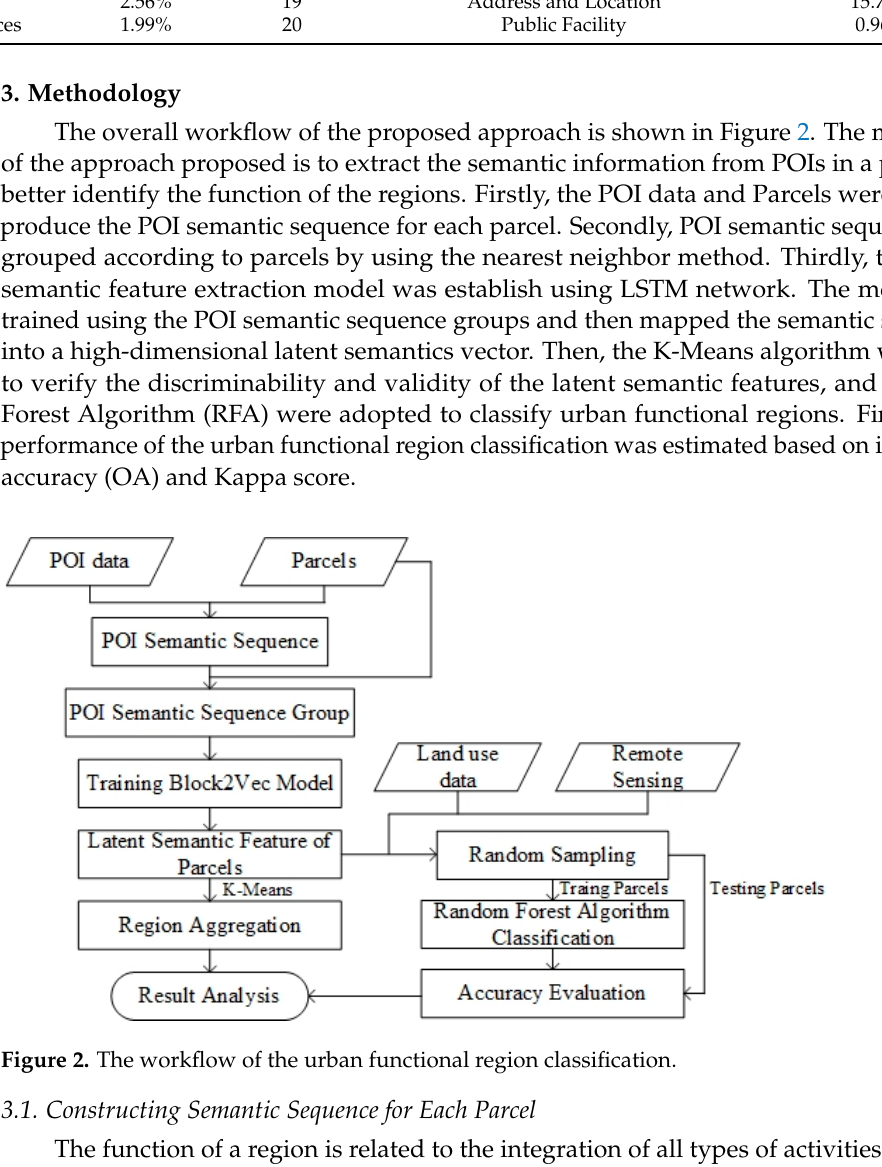
Table 1. The Proportions of primary categories in the study area.